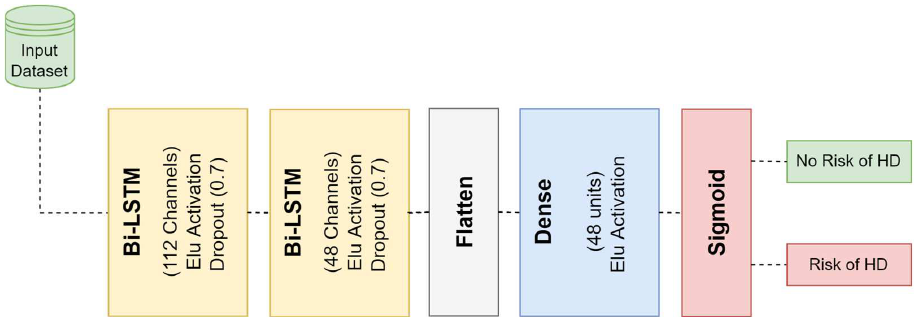
Figure 6. Block diagram of the proposed Bi-LSTM architecture. Table 3. A summary table of the proposed Bi-LSTM model.